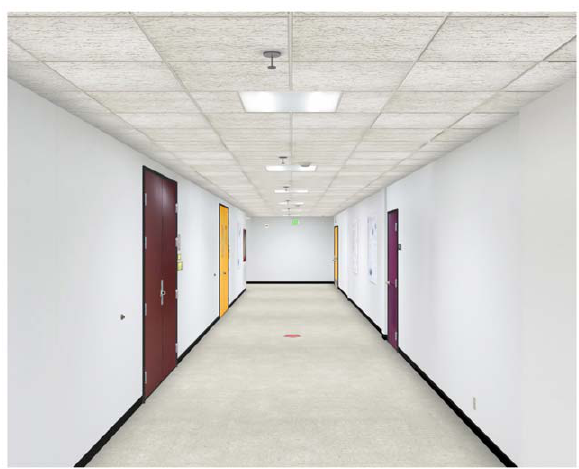
Figure 1. Virtual environment hallway.